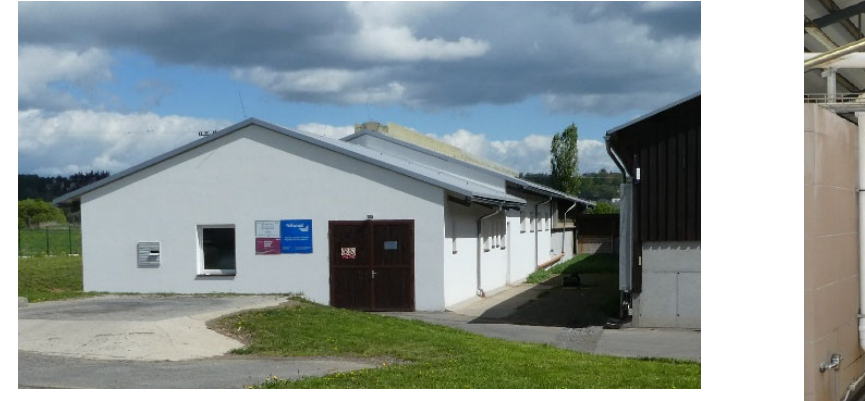
Figure 2. The herringbone milking parlor (MP): ( a ) exterior view; ( b ) the interior of the milking parlor.